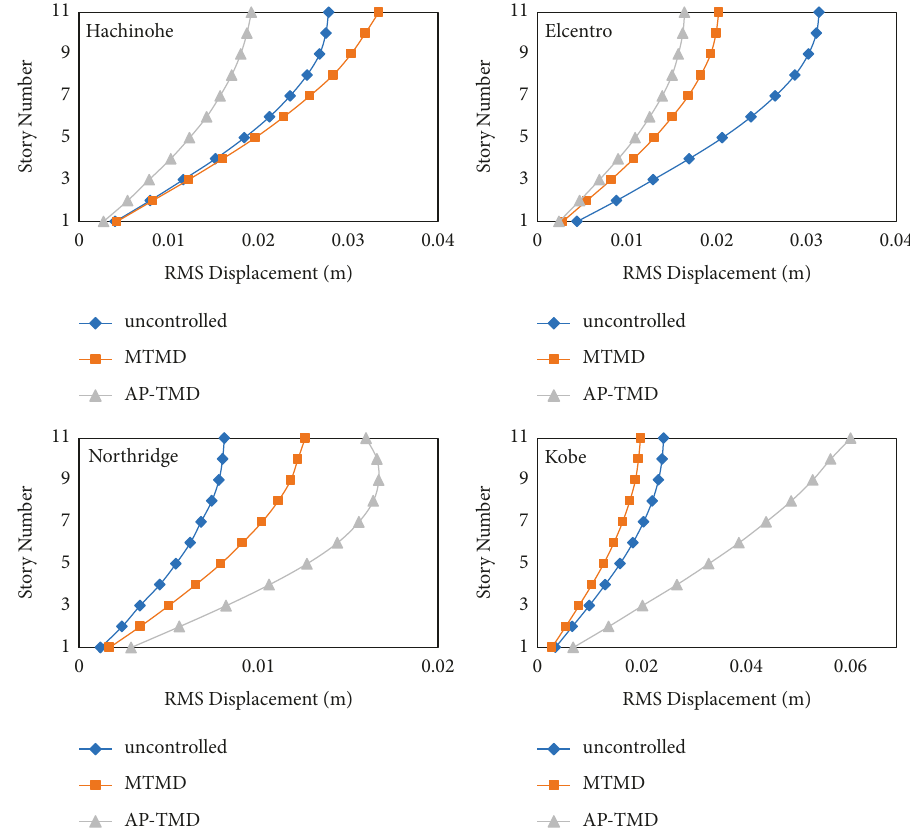
Figure 9: RMS displacement of structural floors with MTMD and AP-TMD controller.